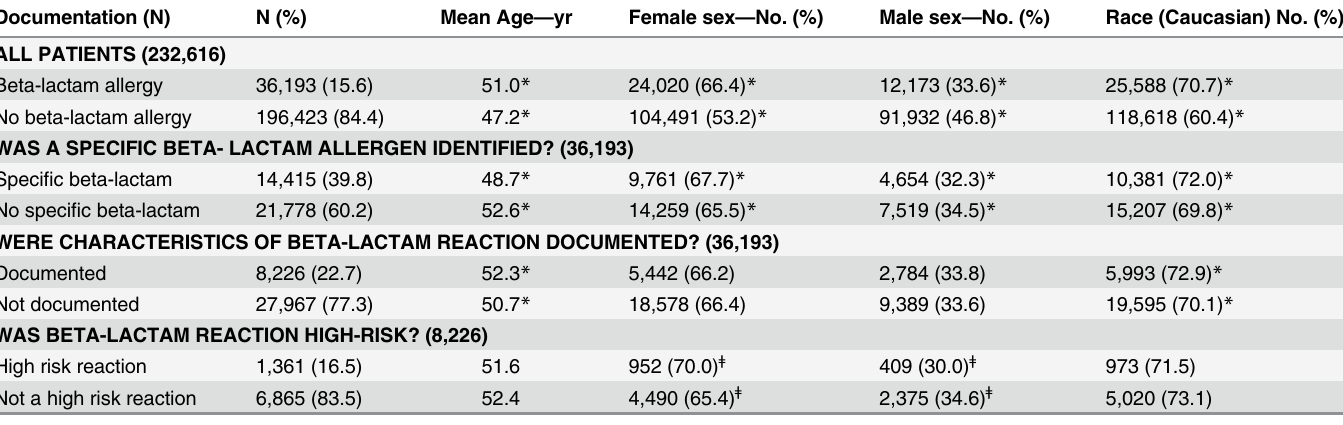
Table 1. Baseline characteristics.